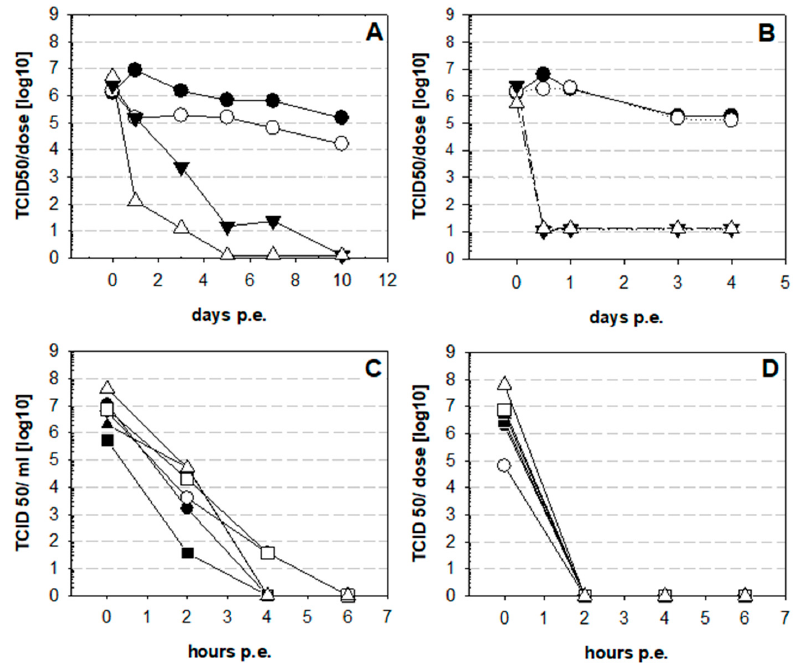
Figure 3. Stability of NDvaccines at elevated temperatures.Vaccine B was tested at elevated tempera- tures as lyophilized preparation in the original tubes ( A ) or dissolved ( B ) at 37 ( • ), 41 ( ◦ C ( ∆ ). Viral titer was normalized to virus dose in the vaccine. In addition, prepared AAF stocks of all six vaccines were tested after exposure to 51 ( C ) or at 61 ◦ C ( D ). Symbols represent vaccine virus A ( • ), vaccine virus B ( (cid:4) ), vaccine virus C ( (cid:78) ), vaccine virus D ( virus F ( ∆